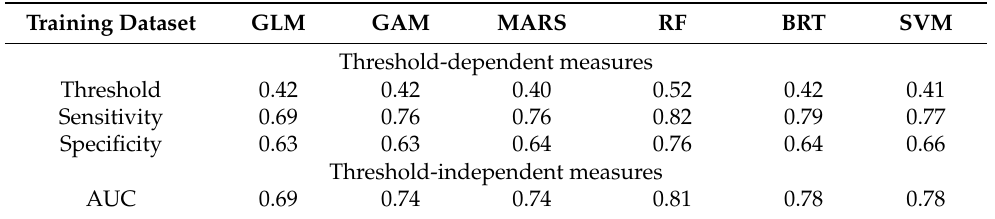
Table 2. Model evaluation of six modelling techniques predicting the distribution of anchovy eggs in the training dataset.